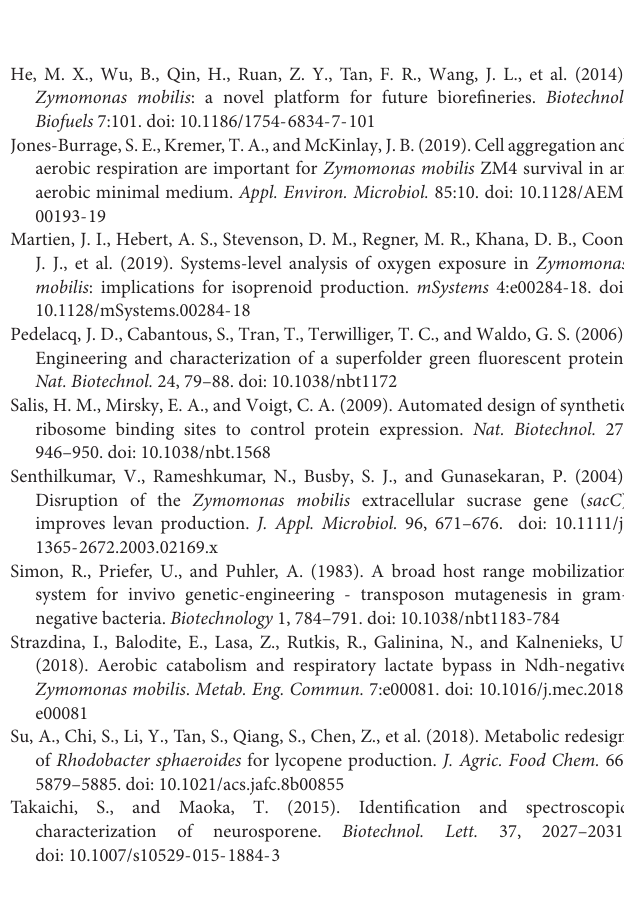
FIGURE S1 | Sequence of the modified genome of Z. mobilis strains. To verify the structure of the insertion or deletion strains, we sequenced across the junction regions of genomic DNA. (A) For the ldh deletion strain, genomic DNA was amplified using primer P34 and P35 and sequenced using primer P34. (B) For deletion of bcsABC , genomic DNA was amplified using primer P22 and P23 and sequenced using primer P22. (C,D) For insertion of the CRT cassette at the ldh locus, we amplified upstream of the CRT cassette using primer P34 and P36 and sequenced using primer P34 (C) and amplified downstream of the CRT cassette using primer P37 and P35 (D) and sequenced using primer P35. Colored arrows indicate junctions of deletion or insertion of heterologous sequence. Top line represents expected sequence of the DNA fragment and the bottom line represents the sequencing